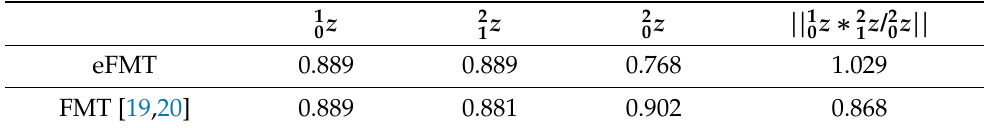
Figure 9. Three rotation and zoom phase shift diagrams (PSD) with multiple zooms. In the first row, the left parts of the input images are further than the right parts w.r.t the camera. Thus there are two peaks in the rotation and zoom PSD. Table 1. Loop Closure for Zoom